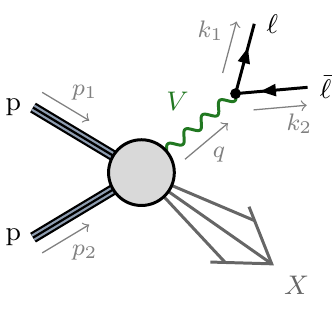
Figure 2 . The de(cid:12)nition of the Collins- Soper [10] angles in the di-lepton rest